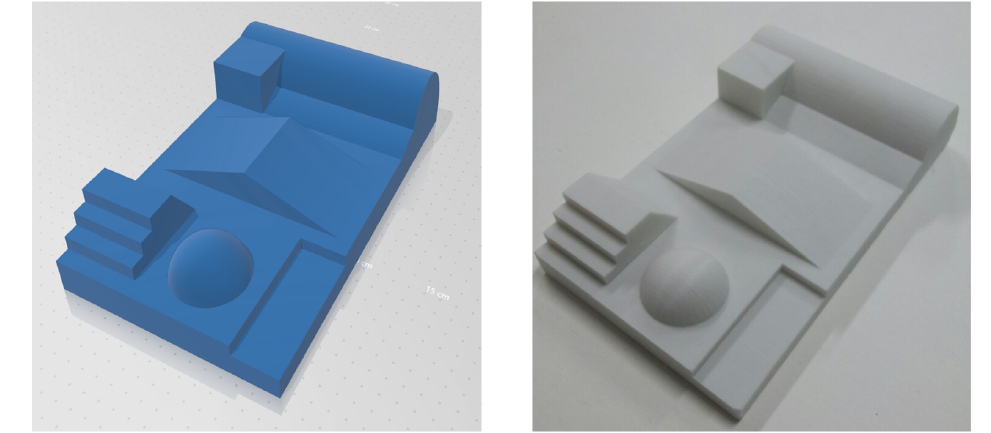
Figure 3. The test object used for the evaluation of feature extraction methods.